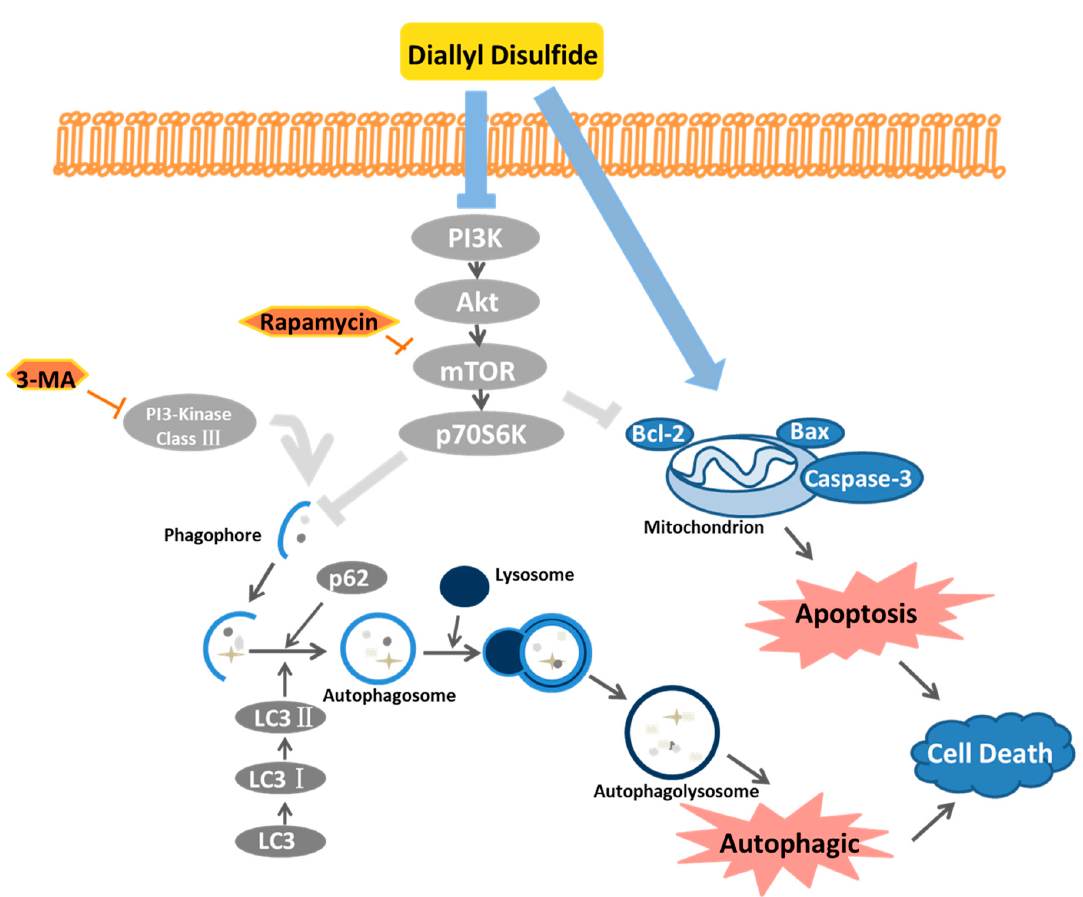
Figure 5. DADs inducing autophagy and apoptosis of human OS cells.